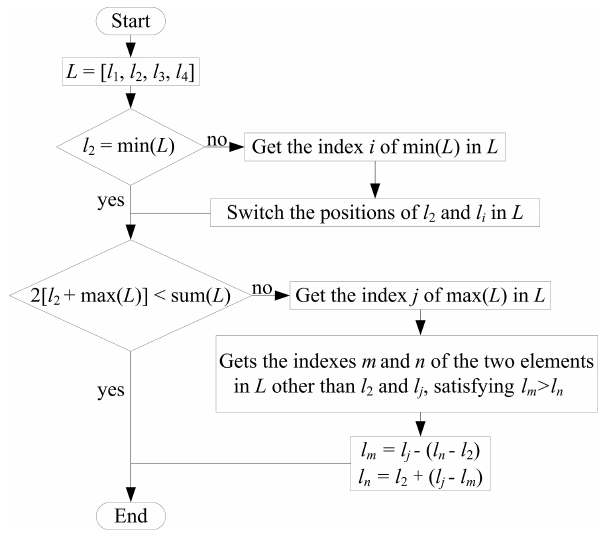
Figure 2. The flow of the linkage repairing technique.